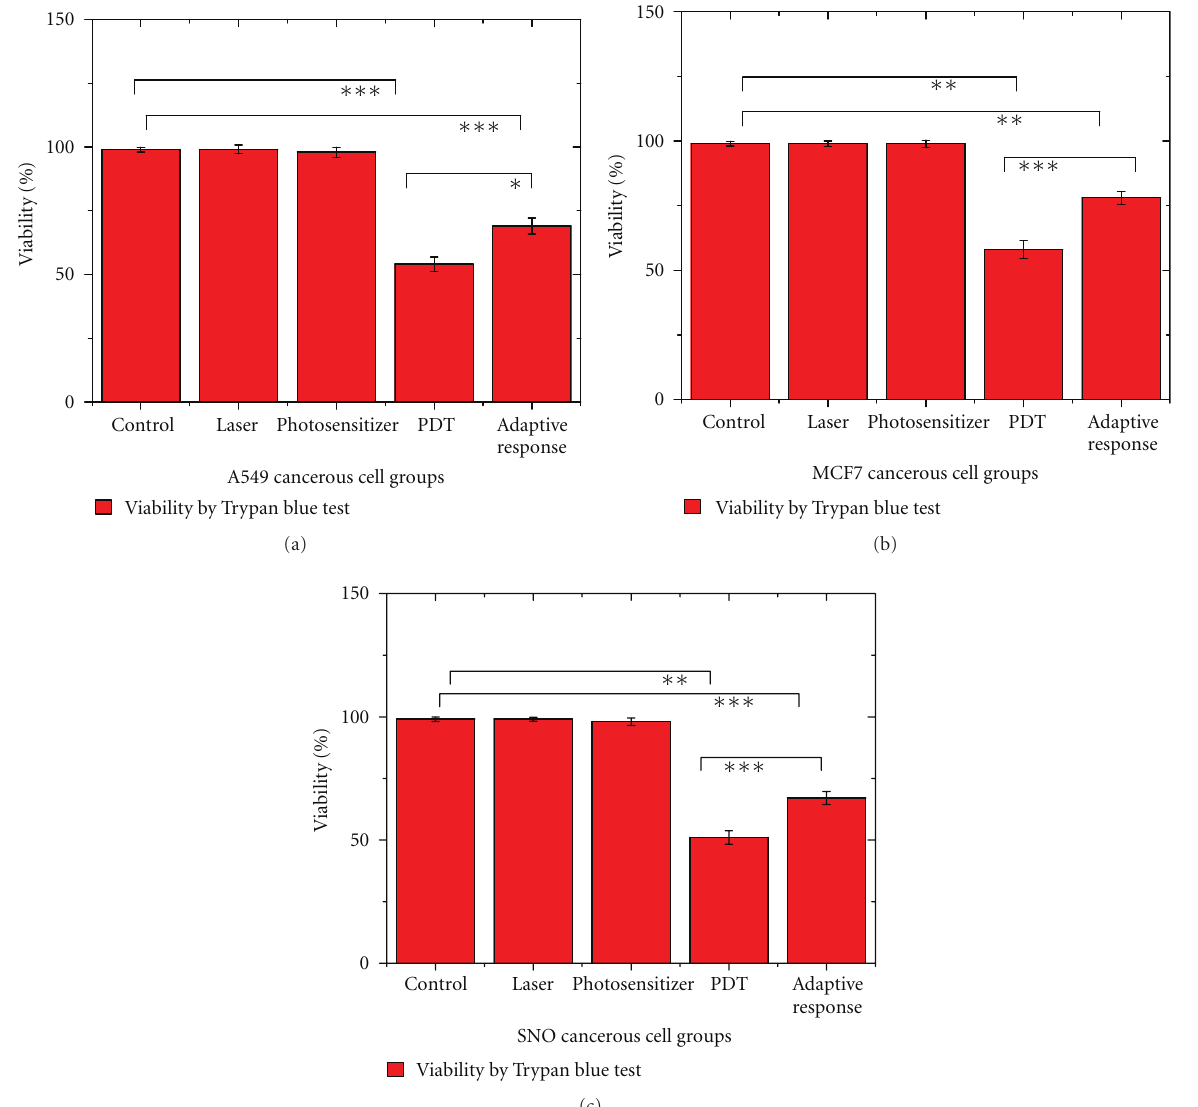
Figure 2: Cell viability expressed as a percentage for the five groups. (a) A549; (b) MCF7; (c) SNO cancer cells. In all three cells types the cells showed a significant decrease in viability after PDT treatment while cells that were pre-sensitized displayed an increase in viability compared to the PDT-treated cells. ( ∗∗∗ P < 0 . 001; ∗∗ P < 0 . 005; ∗ P < 0 .